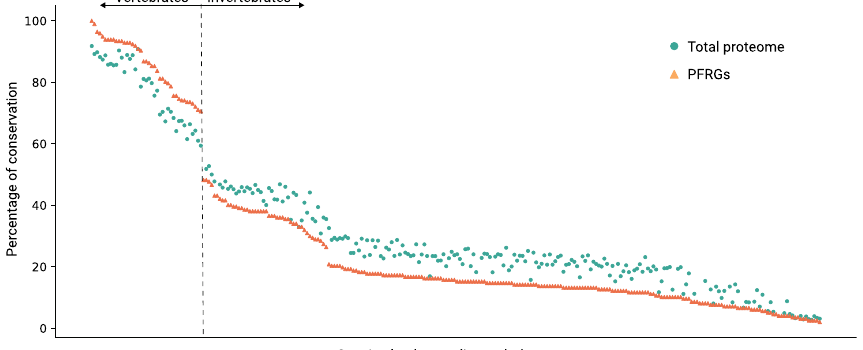
Figure 1. Evolutionary conservation of pulmonary fibrosis-related genes (PFRGs). The graph summarizes the percentages of orthologs between humans and given species. Each dot corresponds to a single species from InParanoid (in descending order by the percentage of orthology). A total of 268 species from all kingdoms of life are presented. Orange triangles stand for the percentage of orthologs for PFRGs (n = 195); green circles stand for the percentage for the entire human genome (n = 20,297). The difference in ortholog percentage between the entire genome and PFRGs is significant for the vast majority of species: Chi-square ( χ 2 ) goodness of fit, p <